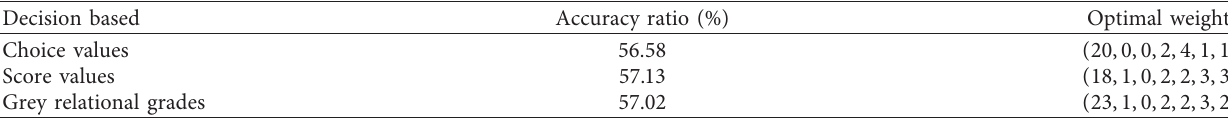
Table 13: The best accuracy ratio.